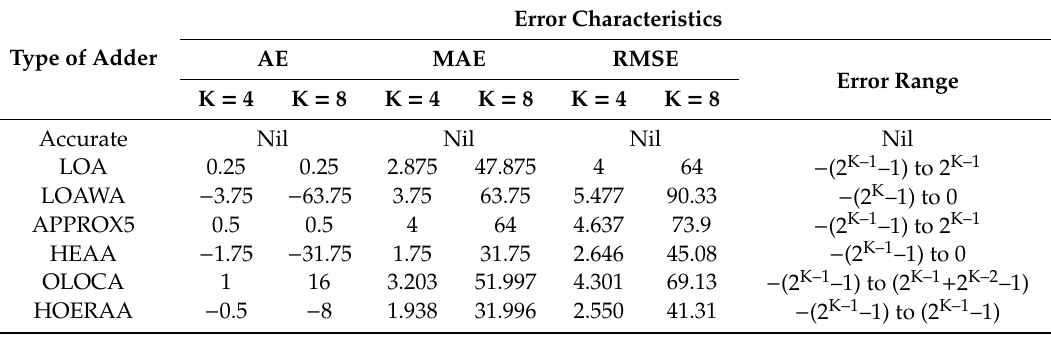
Table 3. Error metrics of the approximate adders shown in Figure 1b–g. Average error (AE), mean average error (MAE), and root mean square error (RMSE) were calculated by considering a 4-bit and an 8-bit inaccurate sub-adder (i.e., K = 4 and K = 8) in the approximate adders. The generalized error range of the approximate adders using a K-bit inaccurate sub-adder is also specified.